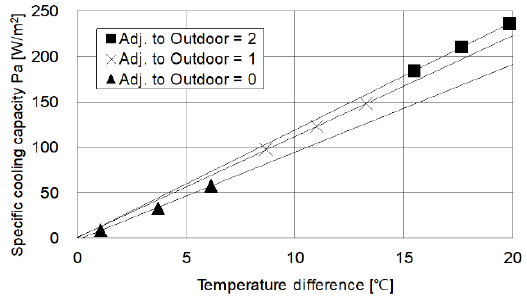
Figure 18. Cooling capacity according to adjacent to outdoor air.